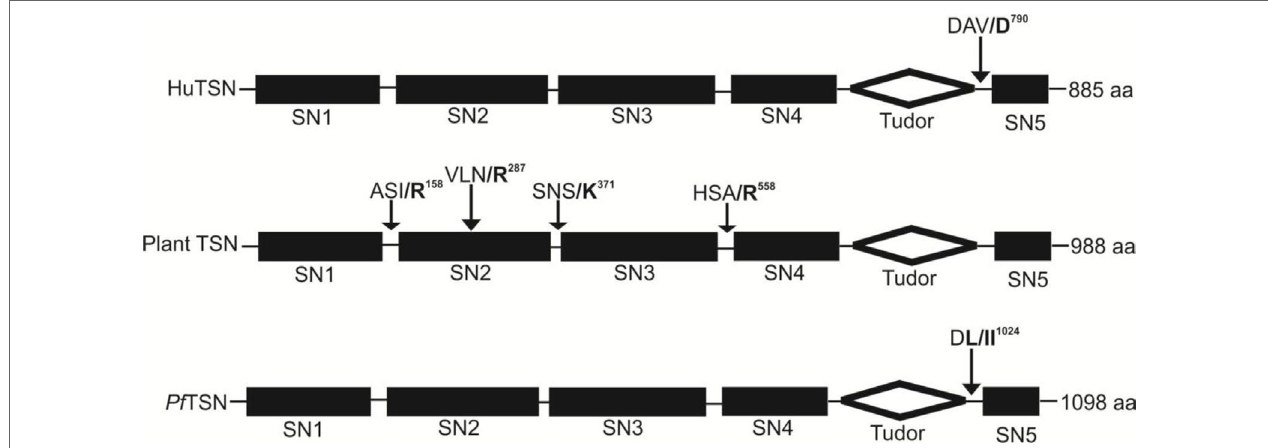
FIGURE 7 | Domains organization of Tudor staphylococcal nuclease (TSN) in human (AAA80488), Plant (CAL38976) and P. falciparum (PF3D7_1136300) and location of MCAs cleavage sites were indicated by arrows. The cleavage of TSN occurred before the bold residues in all presented TSN